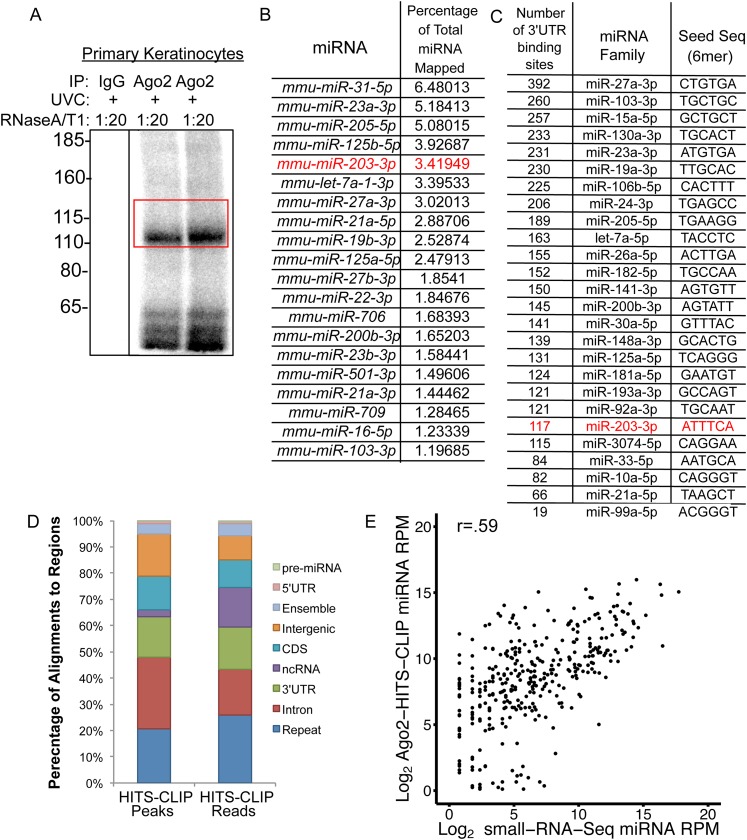
Ago2-HITS-CLIP in primary keratinocytes.(A) Example autoradiogram of isolated Ago2-RNA complexes, red box indicates region excised for sequencing. (B) Proportion of miRNAs detected by Ago2-HITS-CLIP. (C) Number of 3′UTR Ago2 peak containing seed sequences from miRNA families accounting for 90% of all miRNAs in p4 epidermis. (D) Genome-wide distribution of Ago2 peaks and reads. (E) Comparison of miRNAs detected by Ago2-HITS-CLIP and small-RNA-Seq.